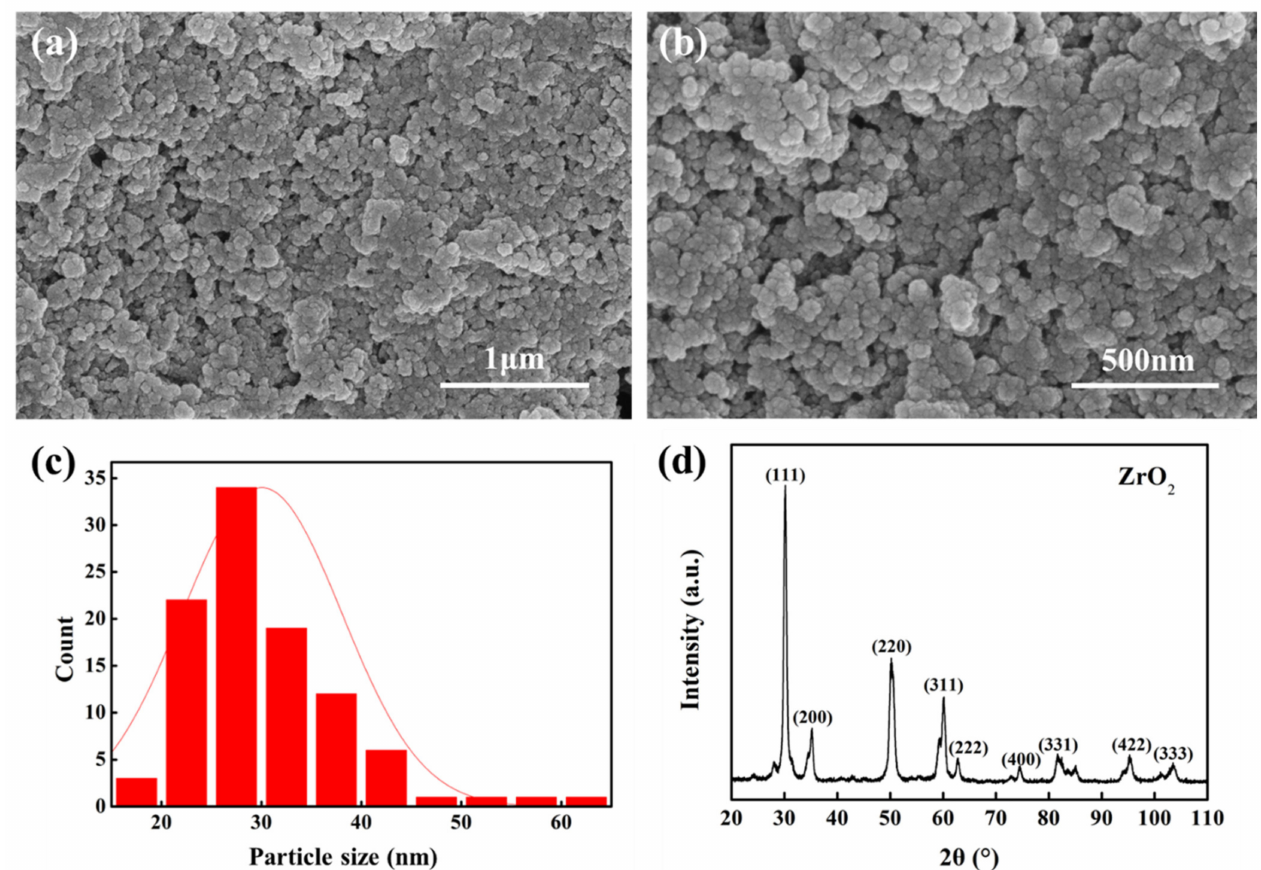
Figure 2. ZrO 2 particles prepared by the hydrothermal method ( a , b ), particle size statistics ( c ), and X-ray phase analysis ( d